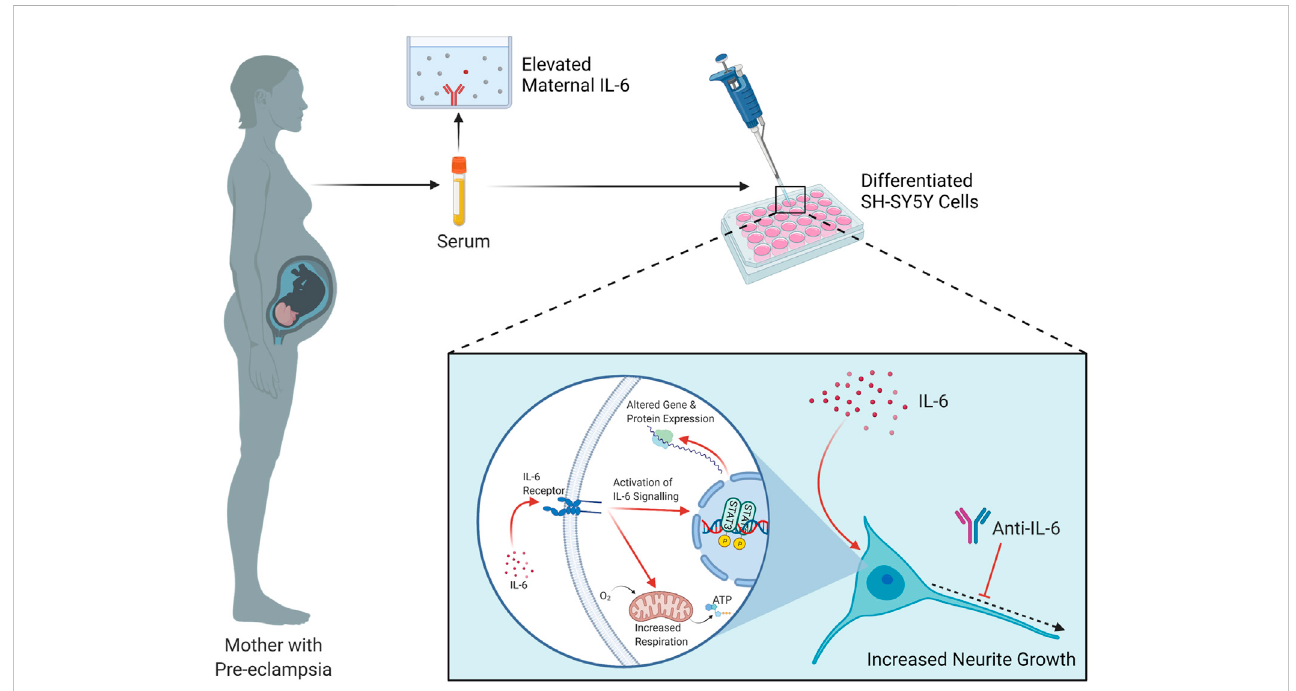
FIGURE 6 Summaryof fi ndingsandproposedmechanism.ElevatedIL-6isdetectedinthecirculationofpregnantwomenwithPre-eclampsia,comparedtohealthy pregnant controls. When applied to RA- or RA/BDNF-differentiated SH-SY5Y cells, this serum induces increases in neurite growth and mitochondrial oxygen consumption. It is proposed that the elevated IL-6 in maternal serum in PE activates the IL-6 signaling pathway in these cells, terminating in the phosphorylation and consequent induction of the transcription factor STAT3 which alters the gene expression pro fi le of the cell, contributing in part to this respiratory and neurite growth increase phenotype. Schematic created with